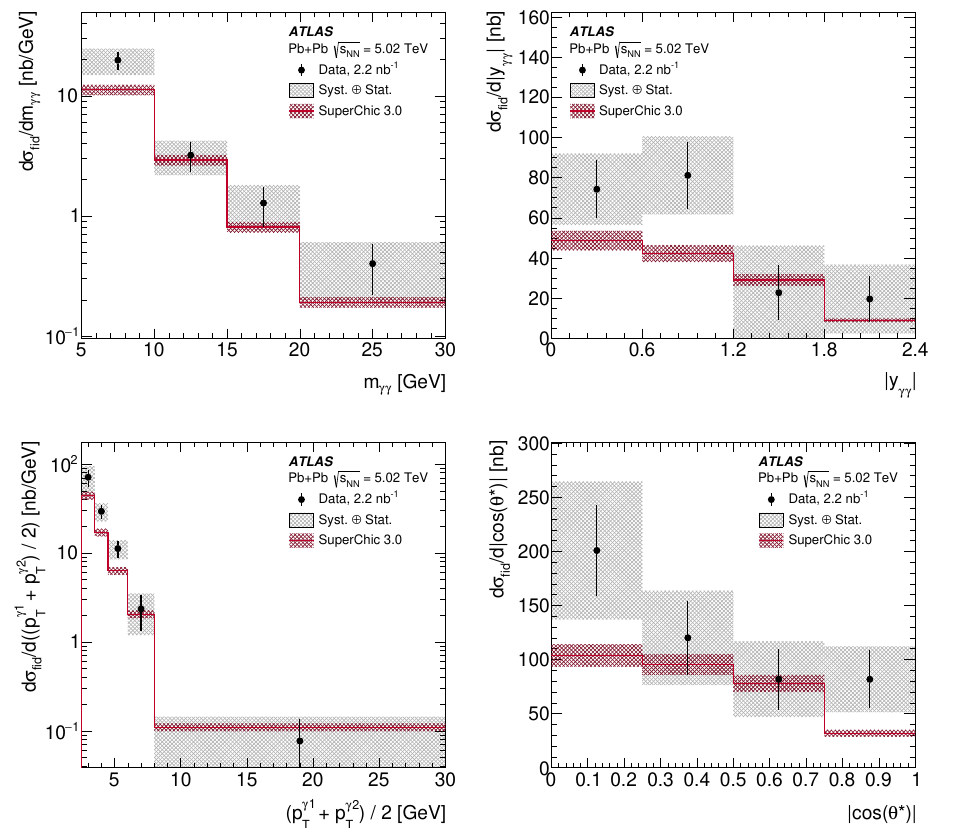
Figure 8 . Measured differential fiducial cross sections of γγ → γγ production in Pb+Pb collisions √ at s = 5 . 02 TeV for four observables (from left to right and top to bottom): diphoton invariant NN mass, diphoton absolute rapidity, average photon transverse momentum and diphoton | cos( θ ∗ ) | . The measured cross-section values are shown as points with error bars giving the statistical un- certainty and grey bands indicating the size of the total uncertainty. The results are compared with the prediction from the SuperChic v3.0 MC generator (solid line) with bands denoting the theoretical